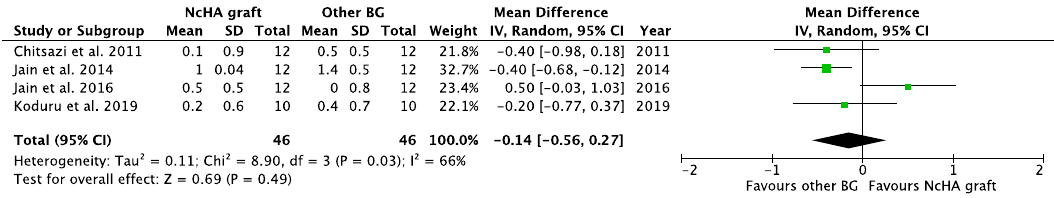
Figure 5. Forest plots demonstrating the comparison of NcHA graft versus other BG (REC change). NcHA: nanohydrox- yapatite; BGs: bone graft; IV: inverse variance; SD: standard deviation; Total: number of patients; 95% CI: confidence in- terval. Table 4. Changes in CAL, PPD, and REC.